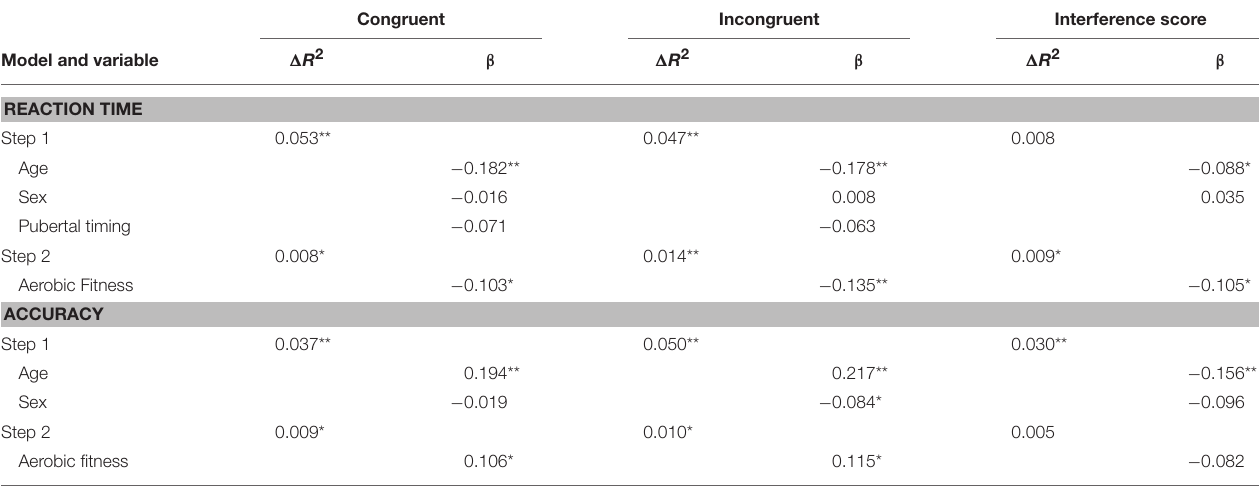
TABLE 3 | Summary of Hierarchical Regression Analyses for Flanker Reaction Time and